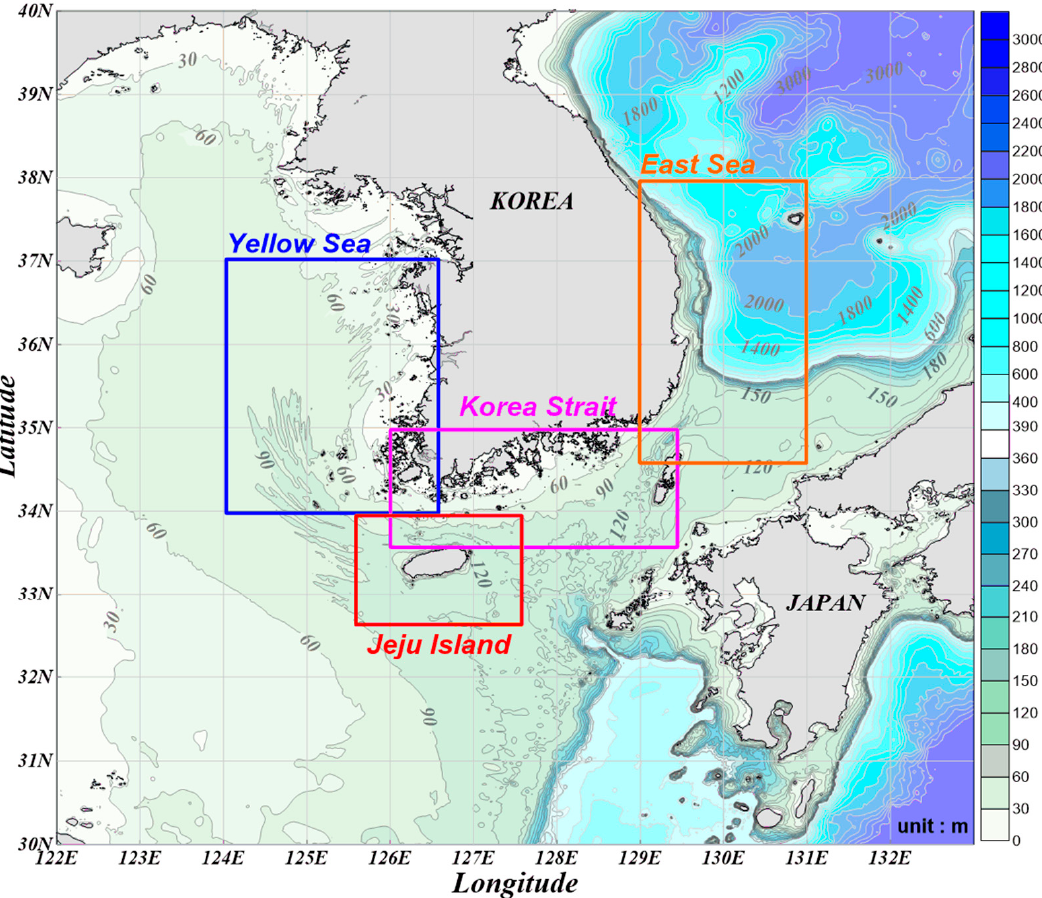
Figure 8. Four selected regions for wave power calculation in the Yellow Sea, Korea Strait, East Sea, and Jeju Island.